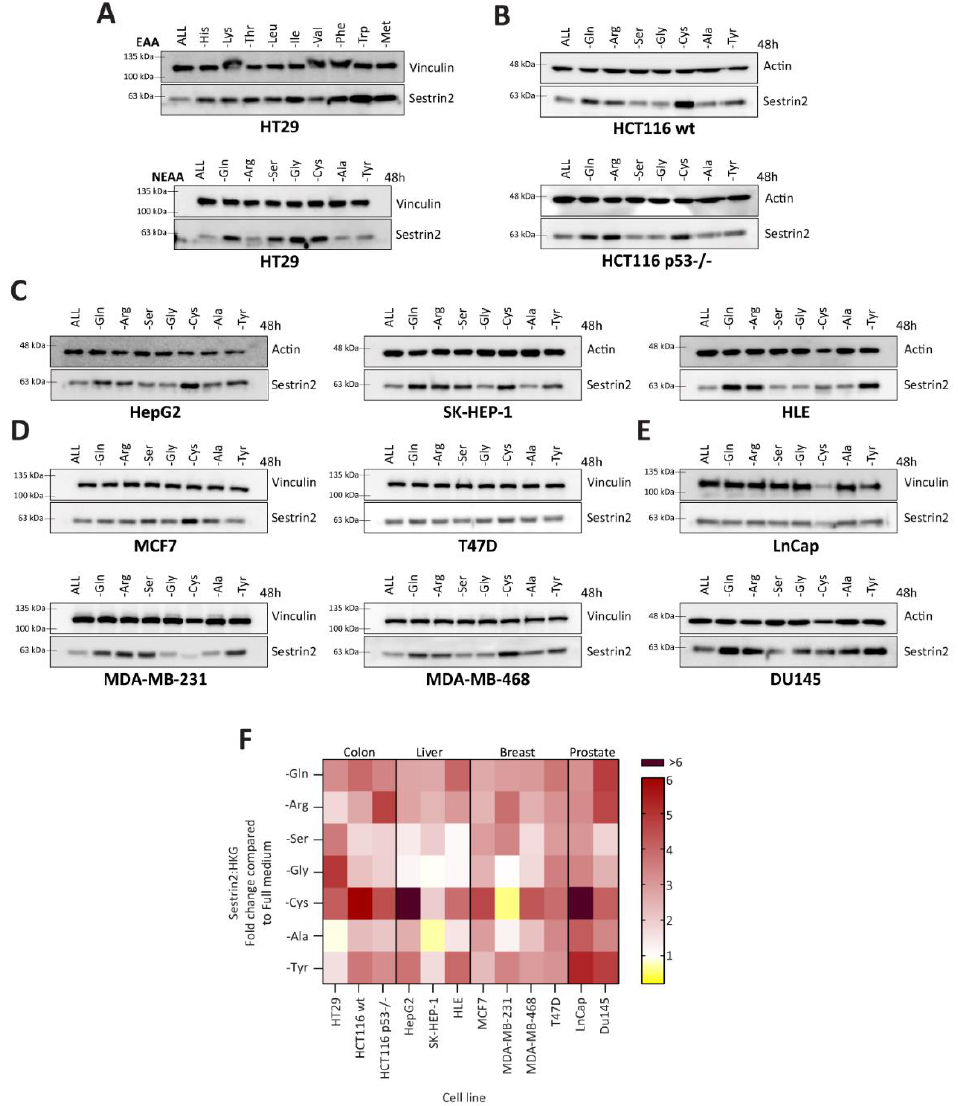
Figure 1. Sestrin2 regulation upon single amino acid deprivation. ( A – E ) Sestrin2 protein levels after two days of amino acid deprivations; ( F ) densitometric quantification of Western blots, Sestrin2 normalized to respective housekeeping gene. EAA—essential amino acids; NEAA—non-essential amino